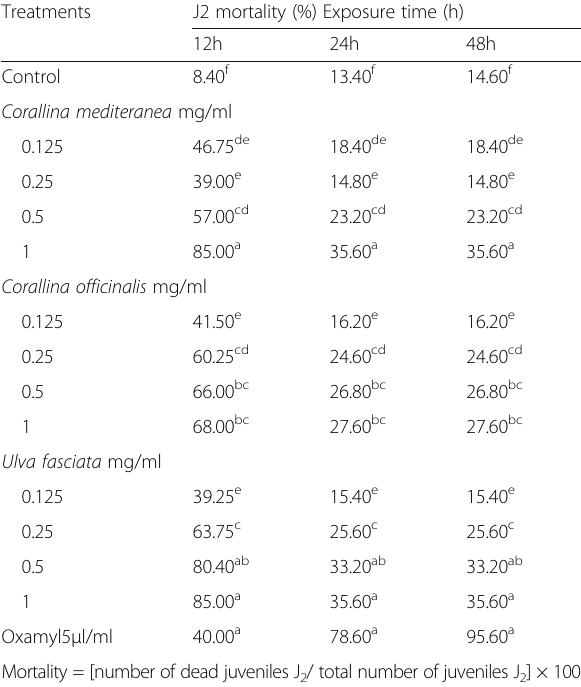
Table 2 Effect of three marine algal extracts on J 2 mortality of Meloidogyne incognita under laboratory conditions Treatments